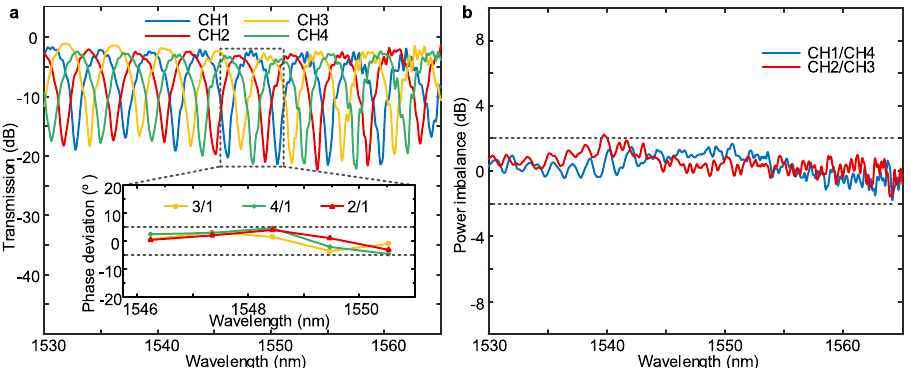
Fig. 2 The 90-degree optical hybrid performance. a Measured transmission of the four output ports in the hybrid. CH stands for the output channel, and the number corresponds to the output port number. Inset: Measured phase deviation of the hybrid. b Measured power imbalance of the hybrid. The blue line (red line) represents the power imbalance between the output channels 1 and 4 (channels 2 and